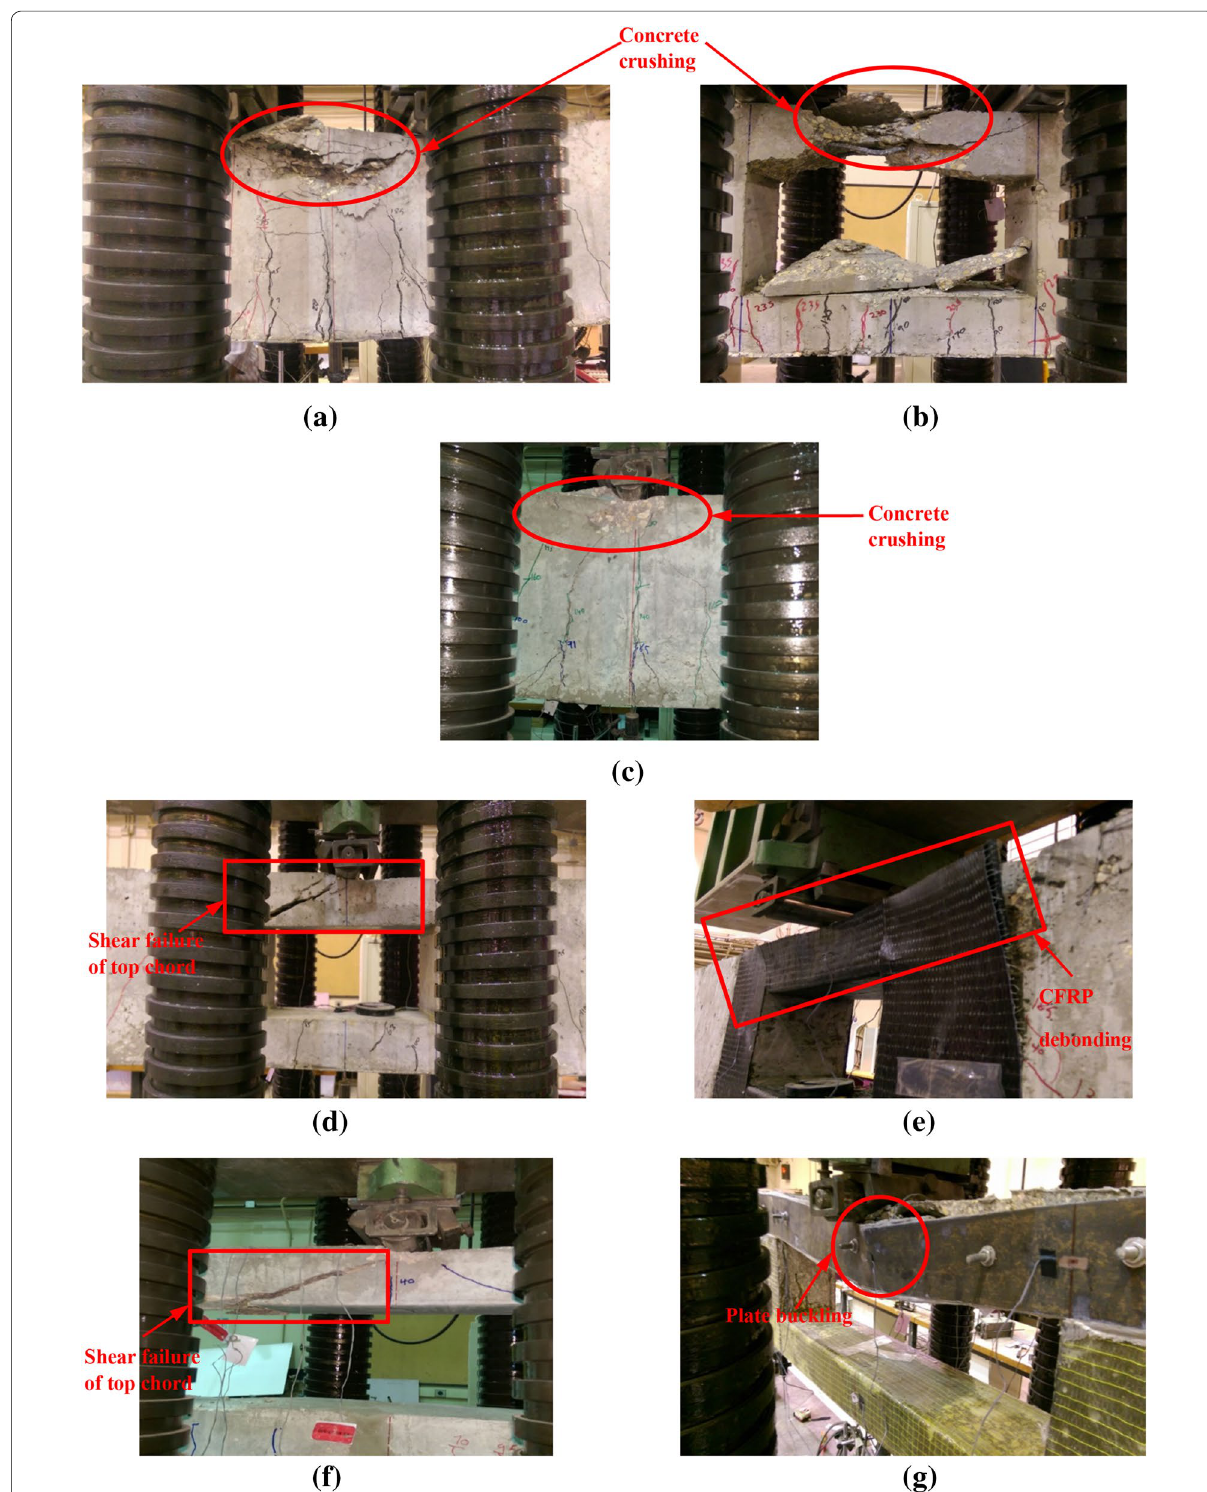
Fig. 10 Mode of failure for: a BC‑N‑4PB, b BC‑O1‑4PB, c BC‑N‑CPL, d BC‑O1‑CPL, e BS1‑O1‑CPL, f BC‑O2‑CPL, and g